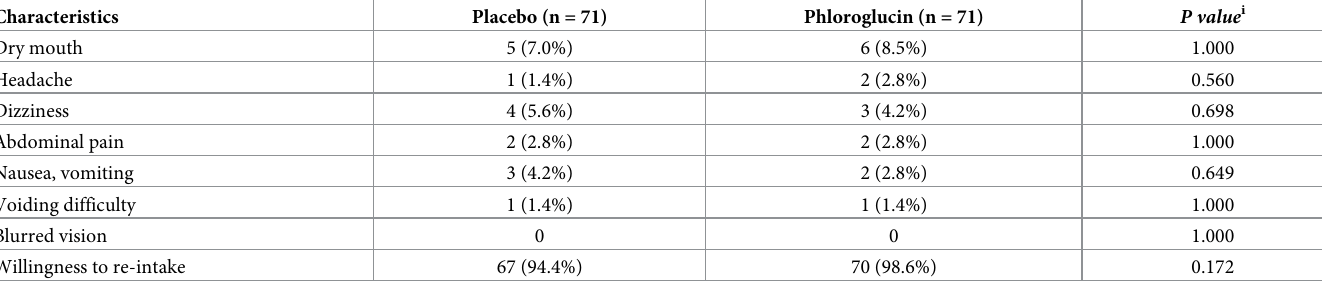
Table 5. Comparisons of adverse events and the willingness of subjects to re-intake the assigned premedication.